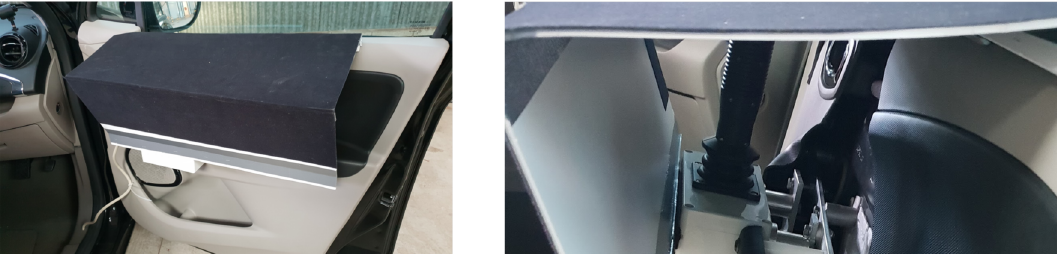
Figure 1. Vedecom (Partner from the H2020 ADAS&ME project: http://www.vedecom.fr) Wizard of Oz (WoZ) system. ( left ) Front-right door and system cover. Interviewer slides their right arm into that cover. ( right ) Hidden joystick inside that cover. This WoZ system does not require an additional control mechanism like dual